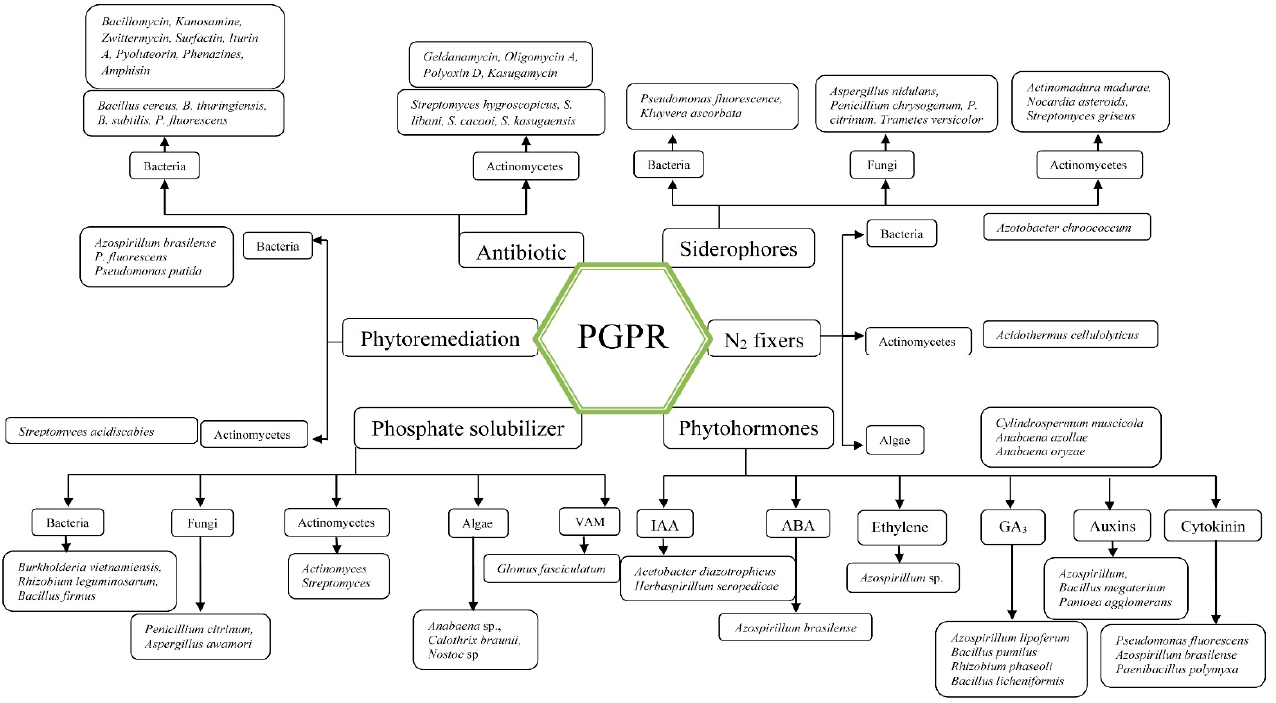
Figure 1. PGPR classification and involved microorganisms. Table 1. Microbial inoculants used as biofertilizers, Plant Growth Promoting Rhizobacteria, and Biopesticides. Biofertilizer PGPR Biopesticide